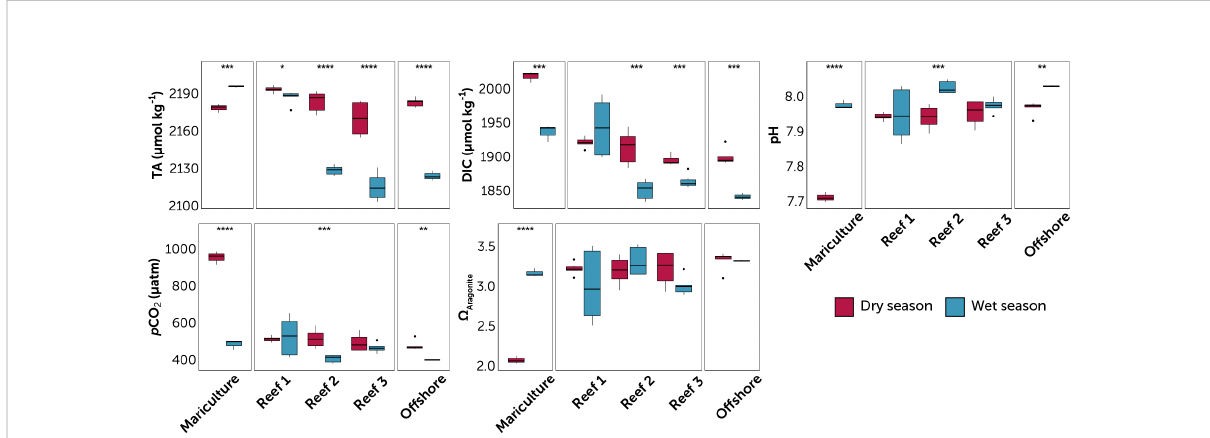
FIGURE 3 Carbonate chemistry parameters at the sampled stations, grouped by station type (mariculture, three reefs, and offshore). Reefs are arranged from nearest (Reef 1) to farthest (Reef 3) from the mariculture station. Data are divided into dry (red) and wet season (blue) for each station.